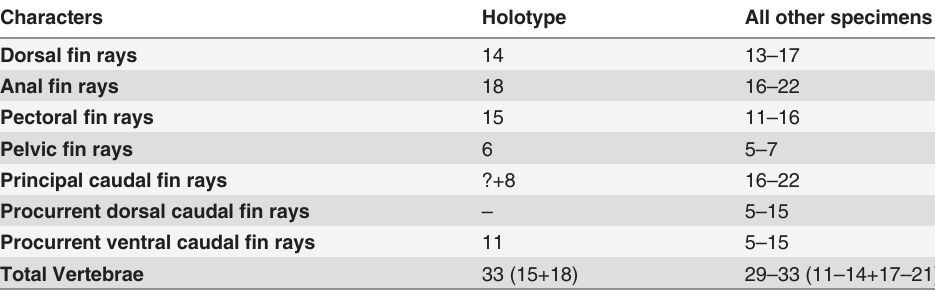
Table 2. Meristic values for † Kenyaichthys gen. et sp. nov. based on the holotype (1209a/b´04) and all other